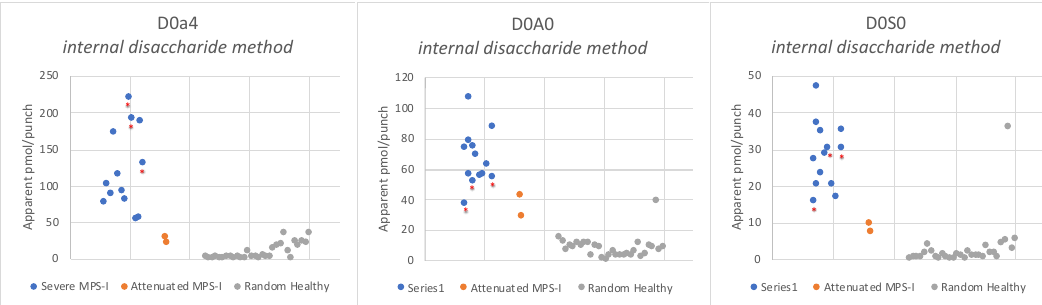
Figure 2. Levels of heparan sulfate-derived (D0A0, D0S0) and dermatan sulfate-derived (D0a4) internal disaccharides measured in dried blood spots (DBS) from newborn mucopolysaccharidosis-I (MPS-I) patients using the internal disaccharide method with heparinase digestion in buffer with Ca 2+ and dithiothreitol. As a result of the limited sample, DBS from attenuated MPS-I patients were processed only in buffer without Ca 2+ and dithiothreitol; however, data in Figure S1 suggest that GAG biomarker levels would not change significantly if Ca 2+ and DTT were used. Note that a single random newborn gave high D0A0 and D0S0 levels. This same sample showed high D0A0 and D0S0 levels in the Sensi-Pro Lite analysis (Figure 7). Asterisked dots are from newborn DBS that were stored at ambient temperature, all others were stored frozen.